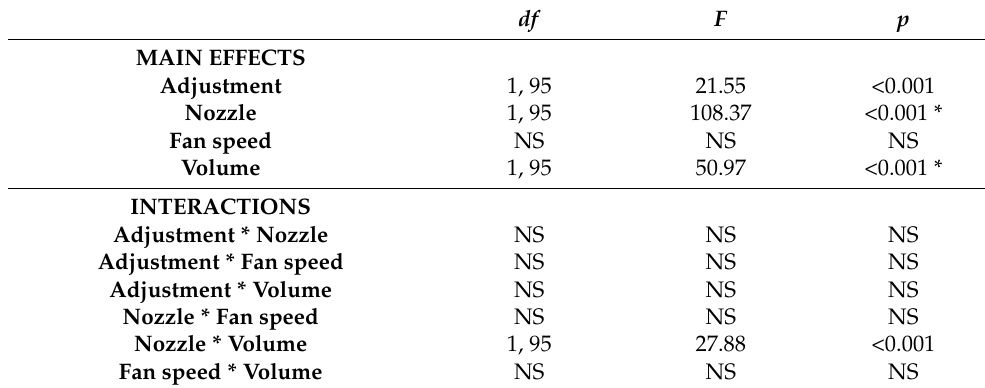
Table 8. Two-way ANOVA results for the normalized volume collected above the Canopy height with the C1 sprayer (least significant difference (LSD) test, p < 0.05) a